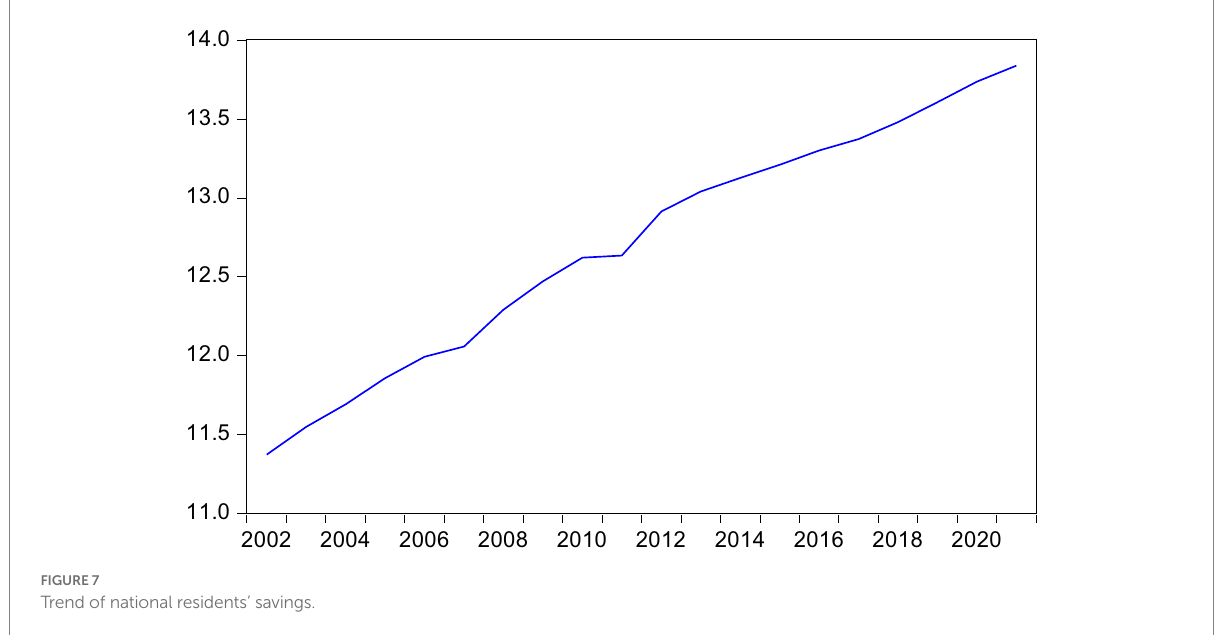
FIGURE 7 Trend of national residents’ savings.